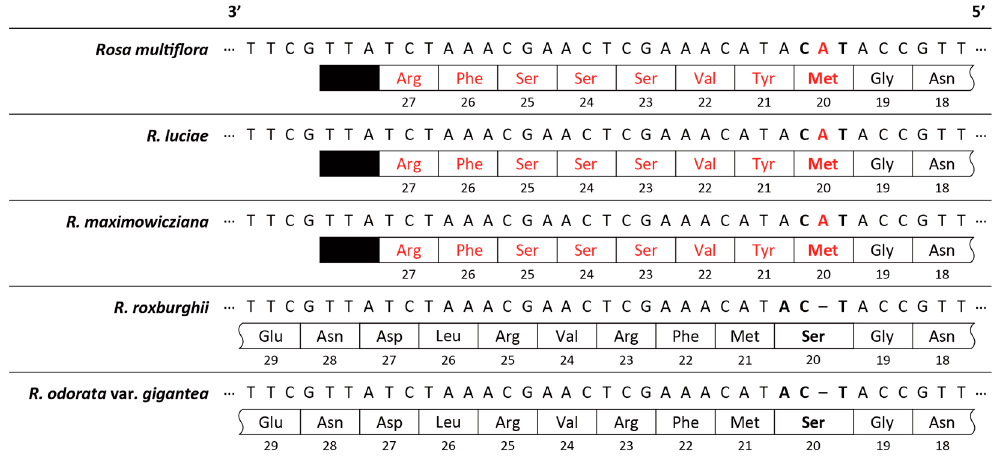
Figure 3. Pseudogenization of infA genes in the Synstylae chloroplast genomes. In each lane, aligned DNA sequence data are shown on the top. Hyphens indicate indels in the sequences. Boxed ribbons show the amino acid sequences coded from the DNA sequences, and black closed boxes indicate the terminal codons. Numbers under the boxes indicates the amino acid residue numbers. The mutated residues are bolded, and mutations are in red.